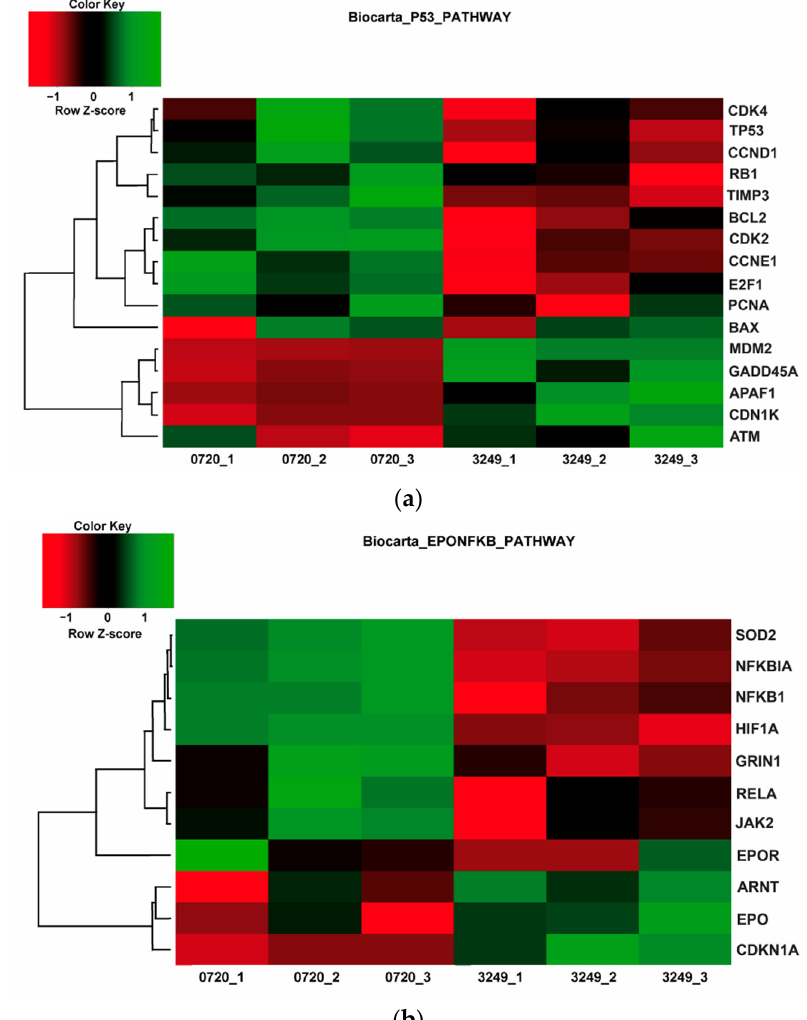
Figure 8. Opposite pattern on heatmaps for Biocarta p53 ( a ) and EPO/NF- κ B ( b ) pathways in response to the treatment with compounds #4896-3249 and #5704-0720. All triplicates for each compound are shown. Experimental details under Materials and Methods.